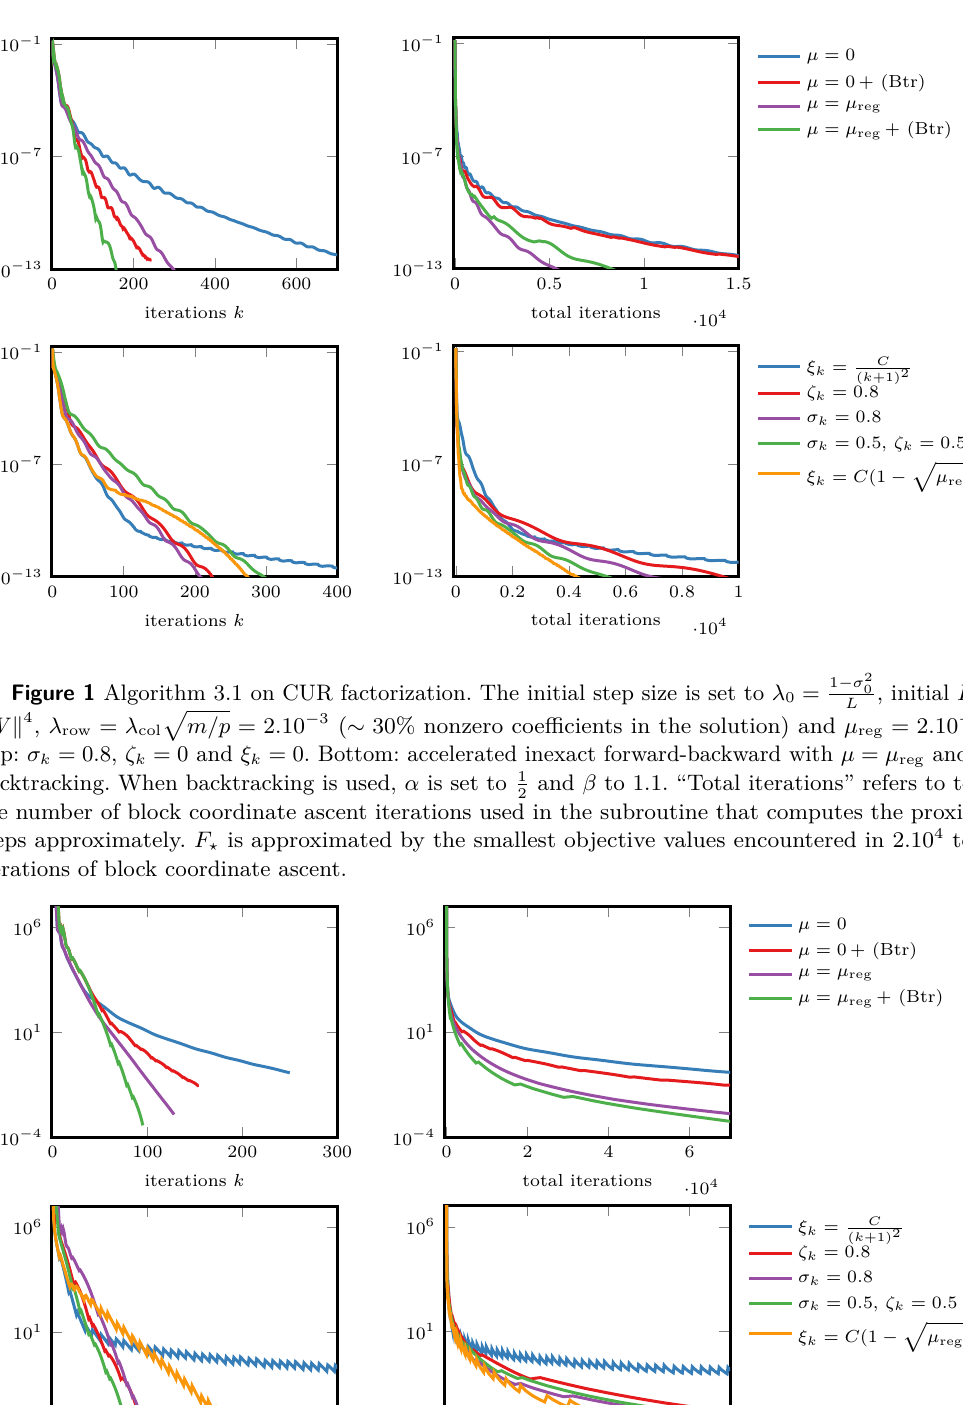
Figure 2 Algorithm 3.1 on TV regularization. The initial step size is set to λ 0 = 1 − σ